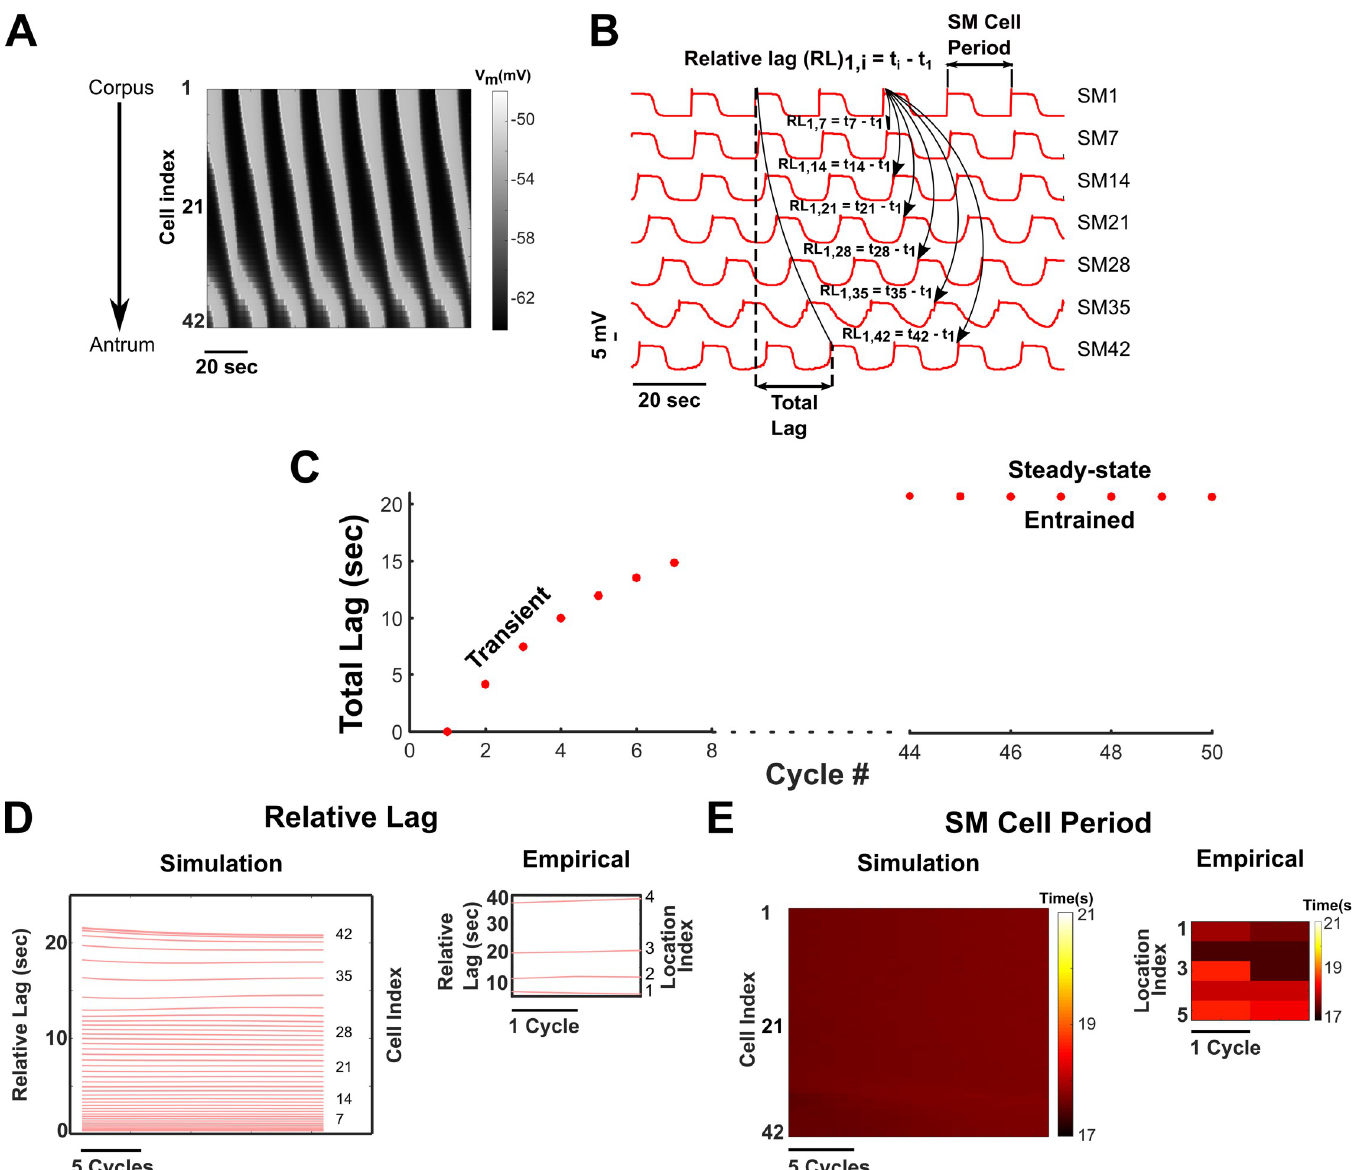
Fig 3. Slow-wave propagation and entrainment in the GMN. (A) Spatiotemporal plot of the SM cell membrane potential along the length of the stomach (vertical axis) and time (horizontal axis) of all 42 SM cells of the network. The direction of slow-wave propagation occurs from the rostral end of the network (representing the mid- corpus) to the caudal end (representing the terminal antrum). (B) The membrane potential of 7 equidistant SM cells in the 42-cell network. (C) Total Lag for the first 7 cycles of simulation and the last 7 cycles of simulation. (D) Relative Lag (RL) between the 1 st SM cell and i th SM cell in the network for the last 20 cycles, where i = 2, 3, 4, ... , 42. (E) Spatiotemporal map of periods of all 42 SM cells in the network for the last 20 cycles. The inset plots for the Relative Lag (Fig 3D) and SM Cell Period (Fig 3E) were generated from the in vitro recordings of SM activity at different locations along the length of the cat stomach [45], where location 1 is the rostral-most